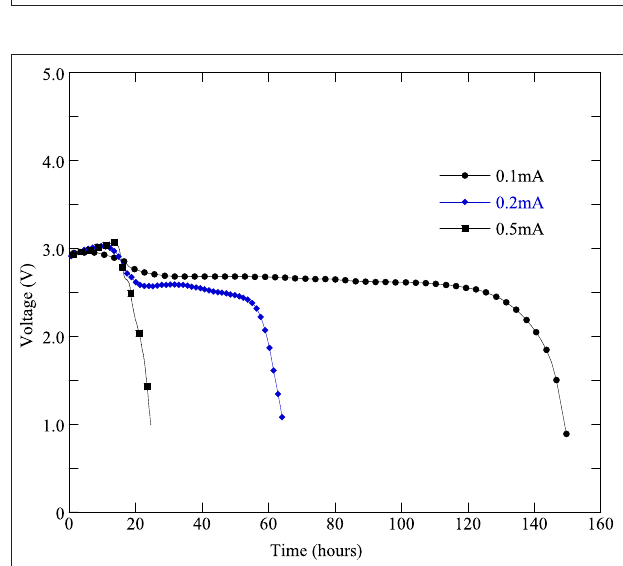
FIGURE 7 | Discharge profiles of the same batch of Li-air battery cells under different discharge current levels: 0.1mA (cell#78C), 0.2mA (cell#78D), and 0.5mA